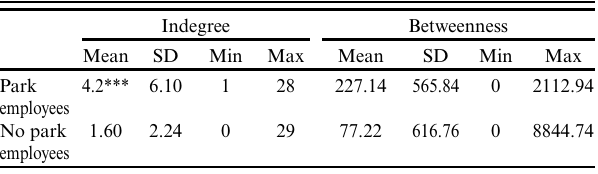
Table 3 . Wilcoxon rank-sum text between individual centrality and working at the natural park (n =